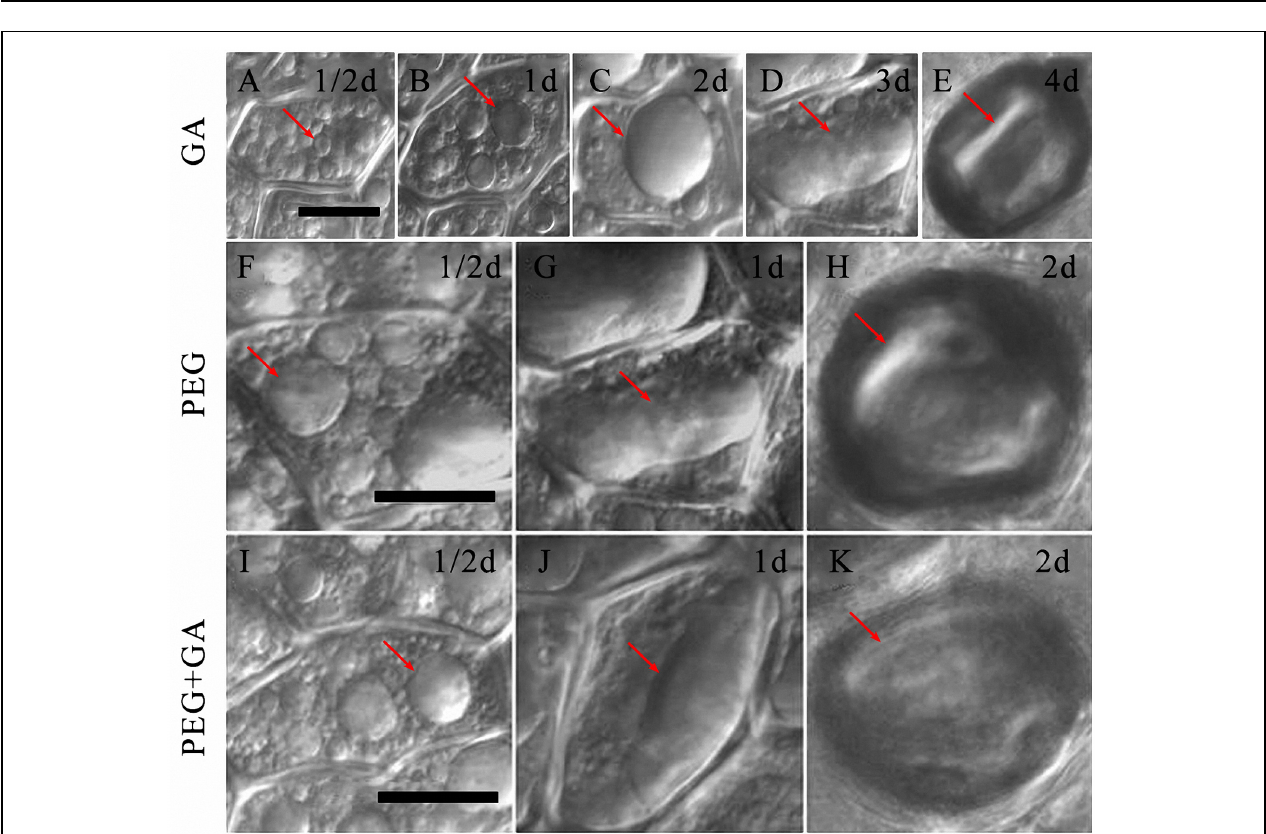
FIGURE 6 | Gibberellin (GA) co-treated with PEG accelerated the vacuolated process of aleurone cells. (A–E) Vacuoles in aleurone cells treated with 50 μ M GA at 1/2, 1, 2, 3, and 4 days. (F–H) Vacuoles in aleurone cells treated with 20% PEG for 1/2, 1, and 2 days. (I–K) Vacuoles in aleurone cells treated with 20% PEG + 50 μ M GA for 1/2, 1, and 2 days. The scale is 20 μ m.